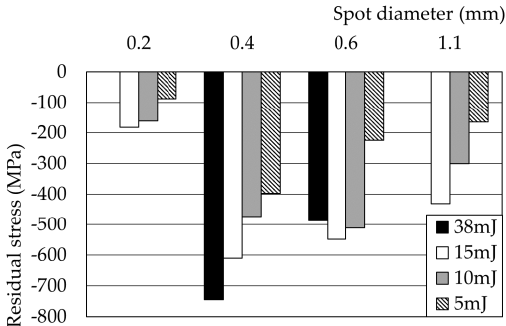
Figure 11. Comparison of maximum residual stress.